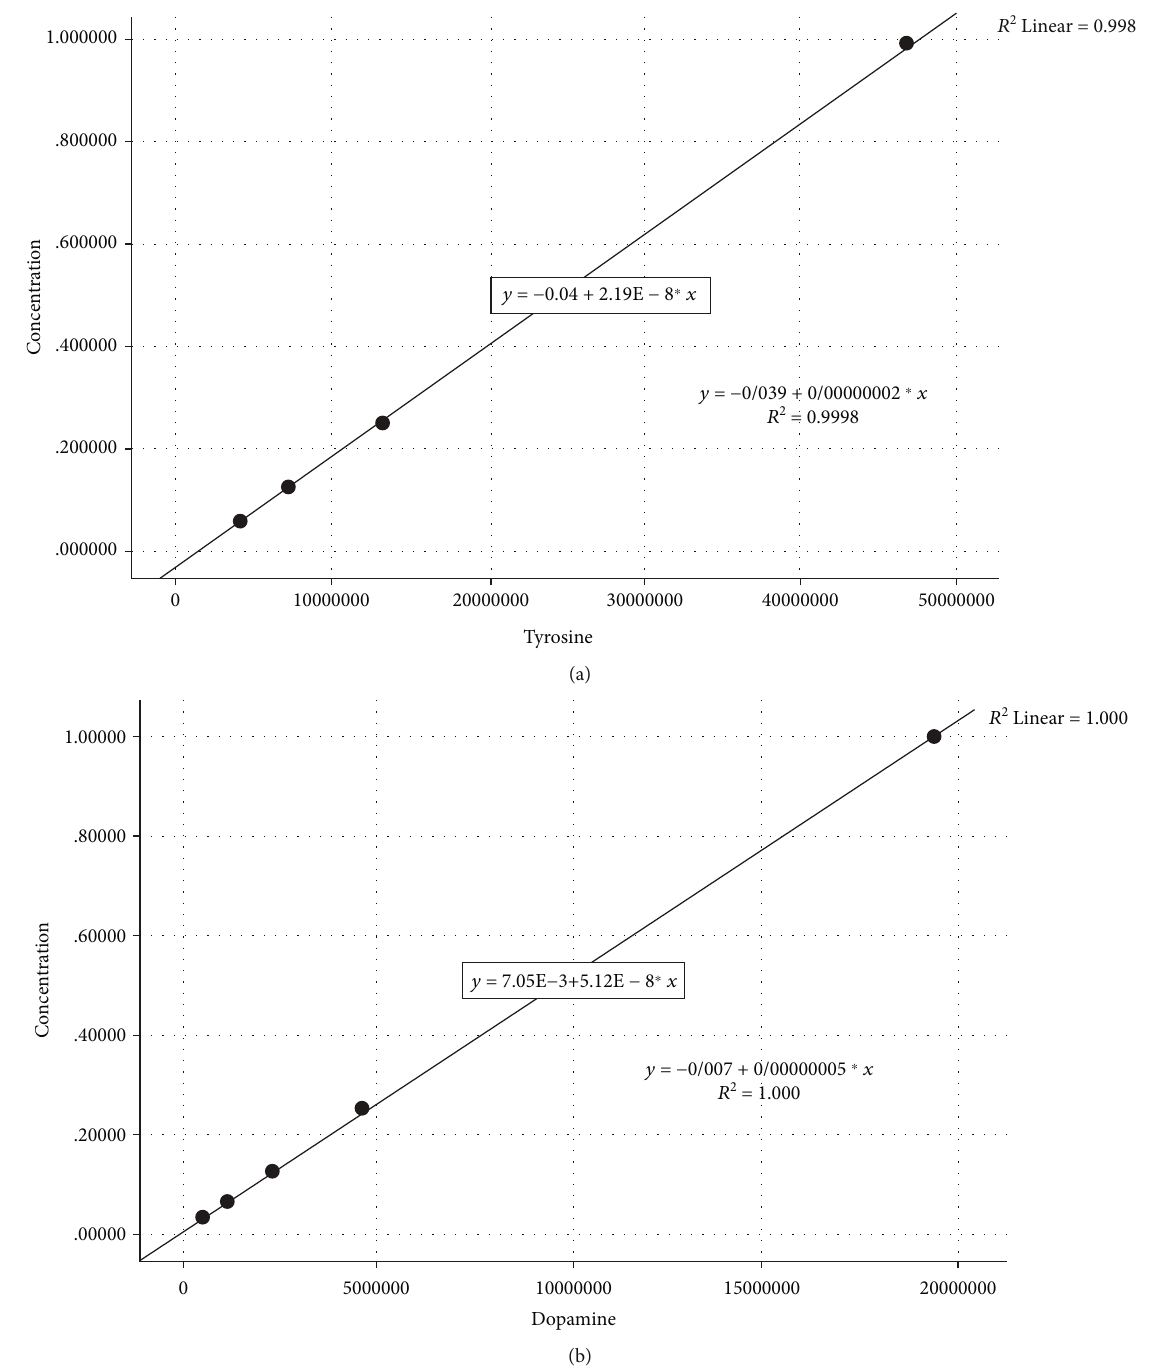
Figure 3: Calibration curves: (a) tyrosine and (b)